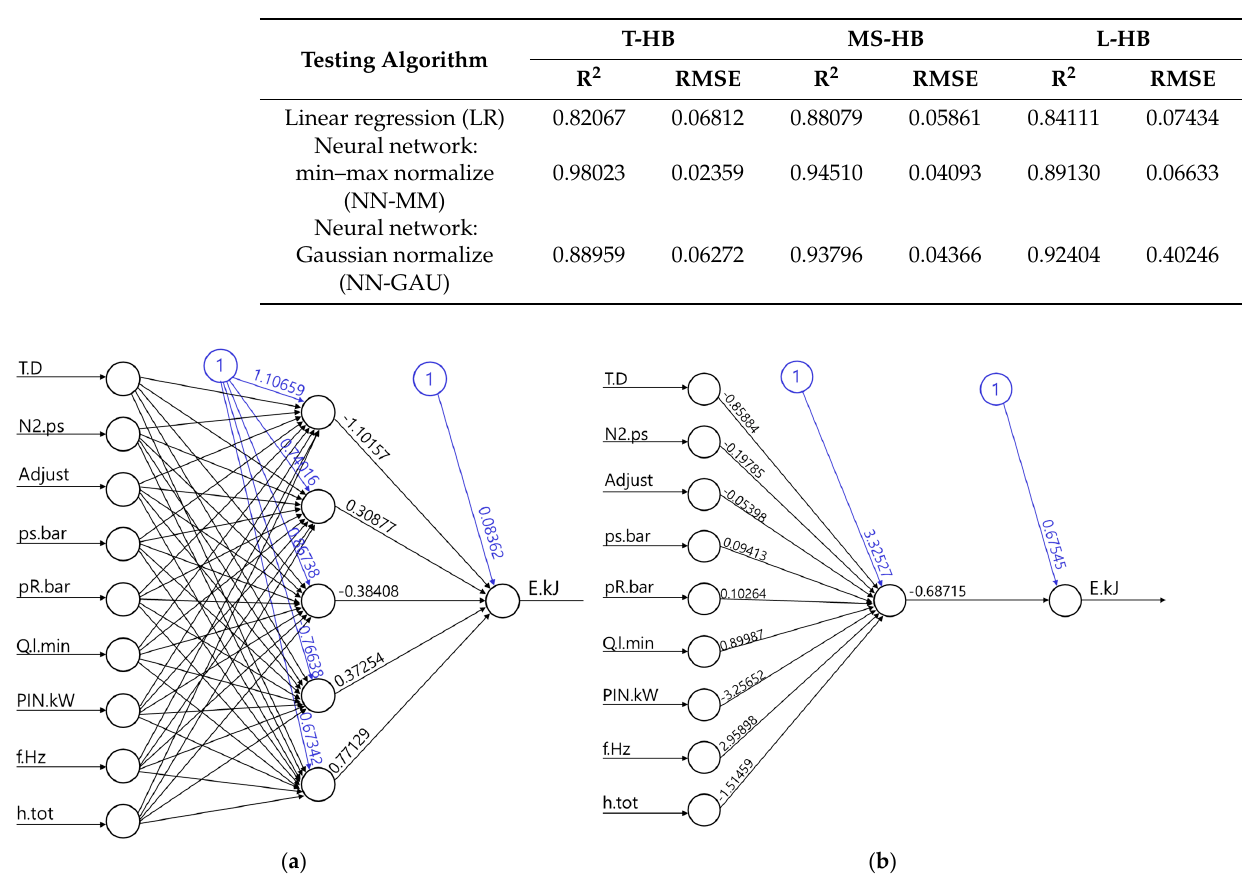
Figure 5. Examples of applying sample hidden layers to a neural network model; ( a ) hidden layer 5; ( b ) hidden layer